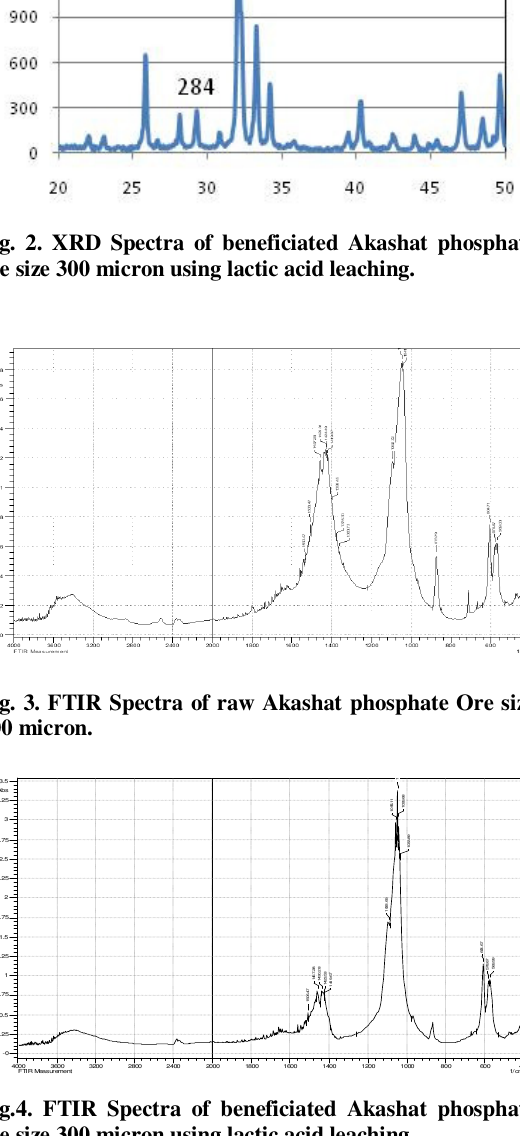
Fig.4. FTIR Spectra of beneficiated Akashat phosphate ore size 300 micron using lactic acid leaching.